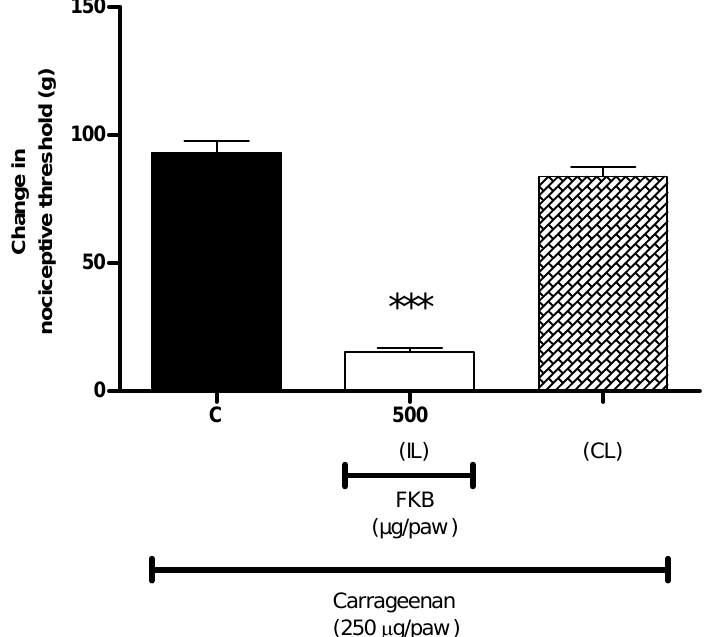
Figure 2. Exclusion of the central or systemic antinociceptive effect of FKB. FKB (500 µg/paw, i.pl.) was administered to the right hind paw 2 h and 45 min following carrageenan administration into both hind paws and nociceptive threshold was measured in the right (ipsilateral; IL) or left (contralateral; CL) hind paw. Each column represents the mean ± S.E.M. ( n = 6). *** p < 0.001 when compared with control (C) group (One-way ANOVA followed by Dunnett’s post hoc